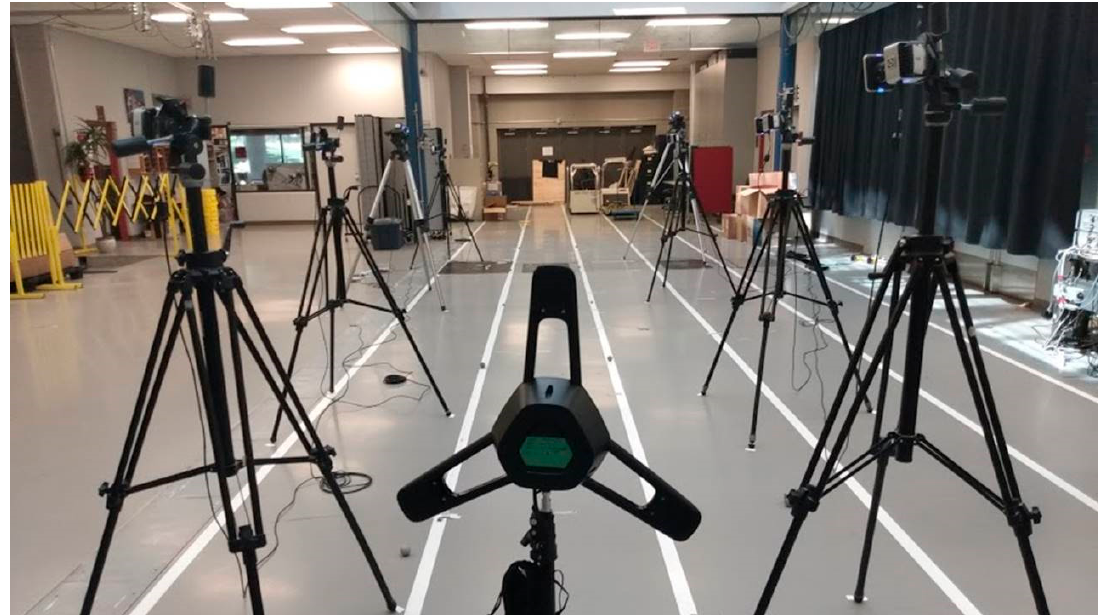
Figure 1. The setup included eight motion capture cameras surrounding the ten-meter-long running lane. The LPS hub was placed on a tripod, 2 m behind the starting position.